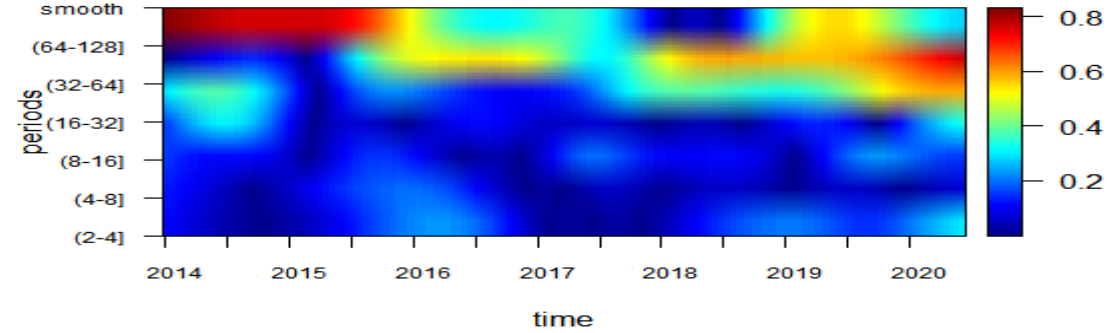
Figure 4. Wavelet multiple correlations between the S&P 500 and SSE stock market returns.